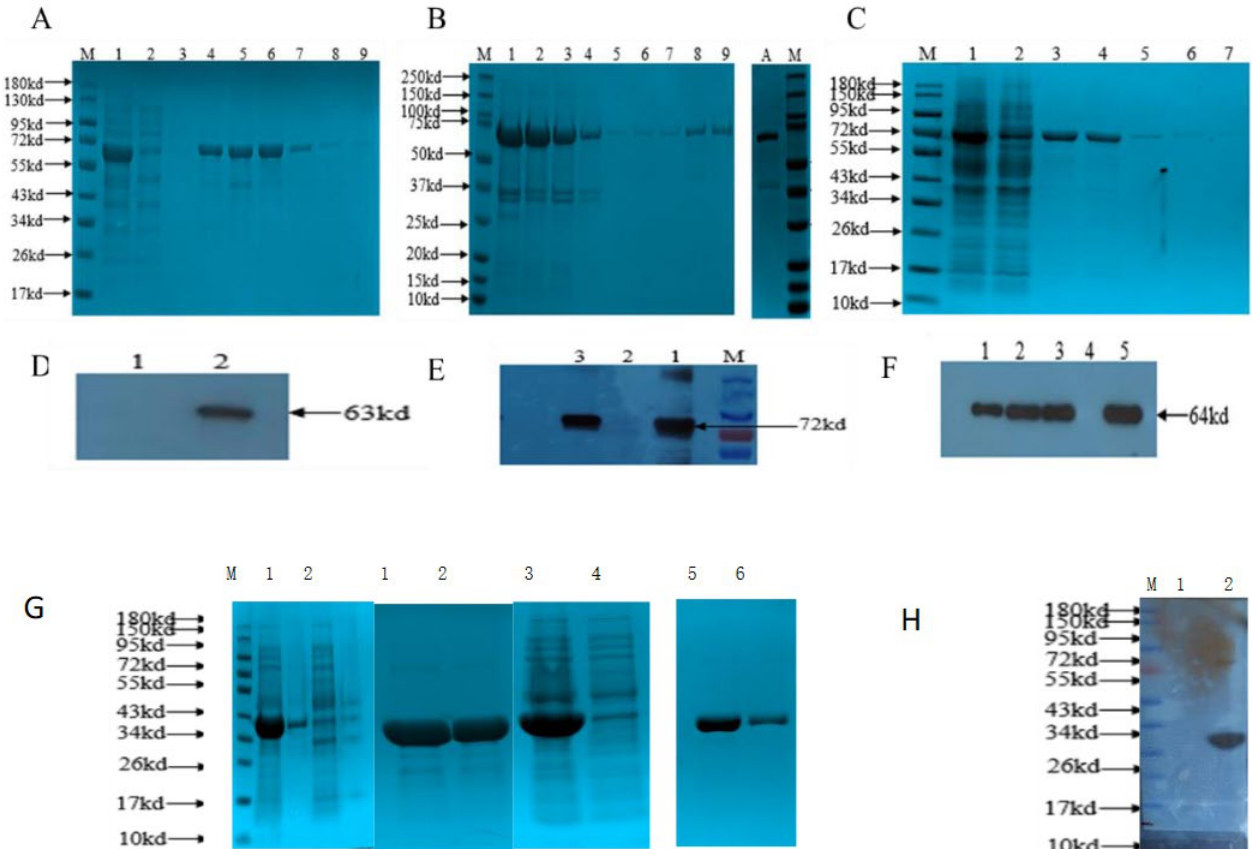
Figure 3. SDS-PAGE and Immunoblot analyses of the pET-32a-HisSumo-VP1/VP0/VP3 fusion protein; Fractions of the protein supernatants and antibodies and other materials were prepared as described in materials and methods. The description of the lanes in each panel is given below ( A – G ). ( A ) SDS-PAGE analysis of pET-32a-His-SUMO-VP1 fusion protein; Protein Molecular Weight Marker; lane 1: Supernatant of pET-32a- His-SUMO -VP1; lane 2: Flow liquid; lane 3–9: Elution liquid E1-E7. ( B ) SDS-PAGE analysis of pET-32a- His-SUMO-VP0 fusion protein; Protein Molecular Weight Marker; lane1: Inclusion body protein; lane2: Flow liquid; lane3–4: Eluted liquid E1-E2; lane5–7: Eluted liquid E3-E5; lane 8–9: Eluted liquid E6-E7; ( C ) SDS-PAGE analysis of pET-32a- His-SUMO-VP3 fusion protein. M: protein Molecular Weight Marker; 1: Supernatant of pET-32a- His-SUMO-VP1; 2: Flow liquid; 3–7: Elution liquid E1-E5. ( D – F ) show the result of